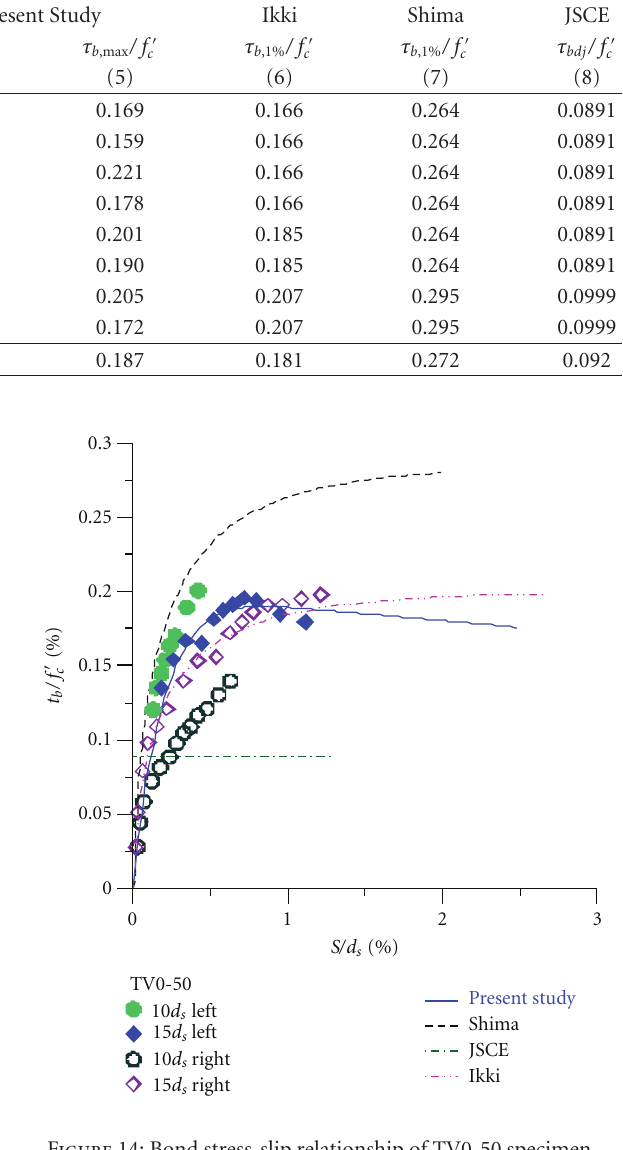
Figure 13: Bond stress-slip relationship of TV0-45 specimen. Figure 14: Bond stress-slip relationship of TV0-50